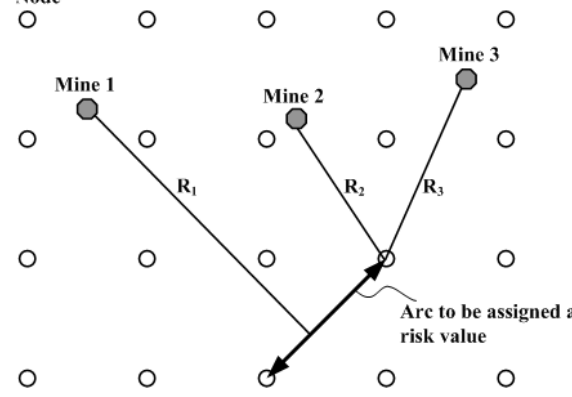
Figure 3: Principle of assigning a risk value to an